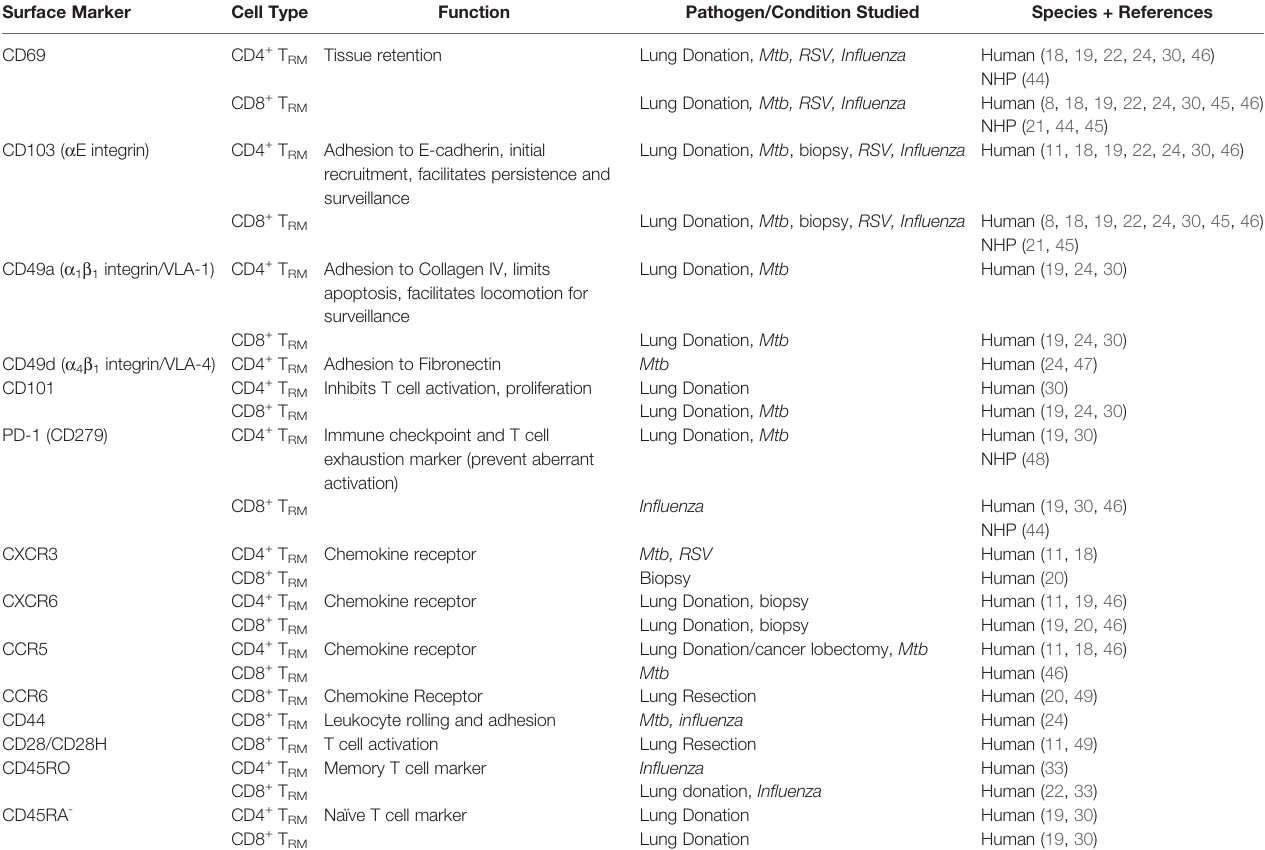
TABLE 1 | Human and Non-Human Primate Surface Marker Expression on Pulmonary T RM .